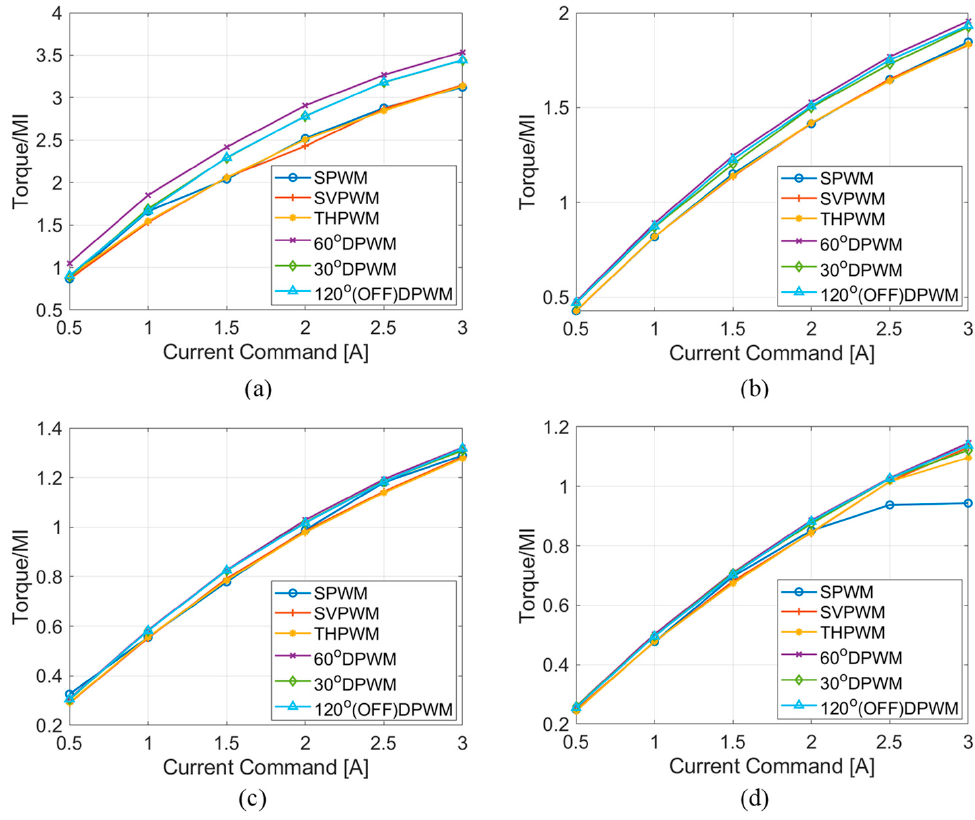
Figure 19. Experimental results of torque per MI depending on the PWM technique at ( a ) 200 rpm; ( b ) 600 rpm; ( c ) 1000 rpm; ( d ) 1200 rpm.